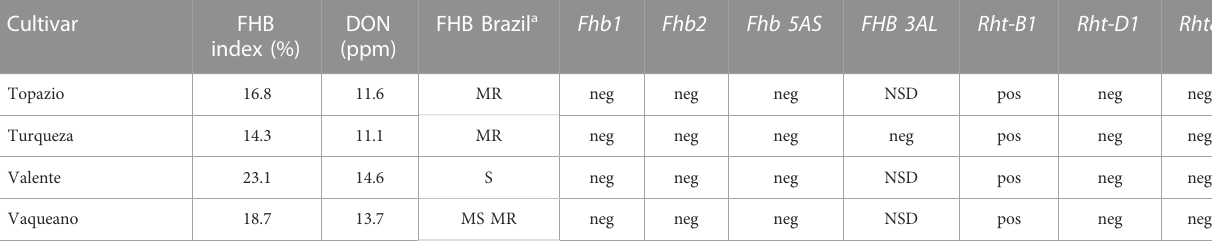
to the Ug99 stem rust race TTKSK. Both collections were fi eld evaluated at Morden (MB) in 2017 and 2018 with severity ranging